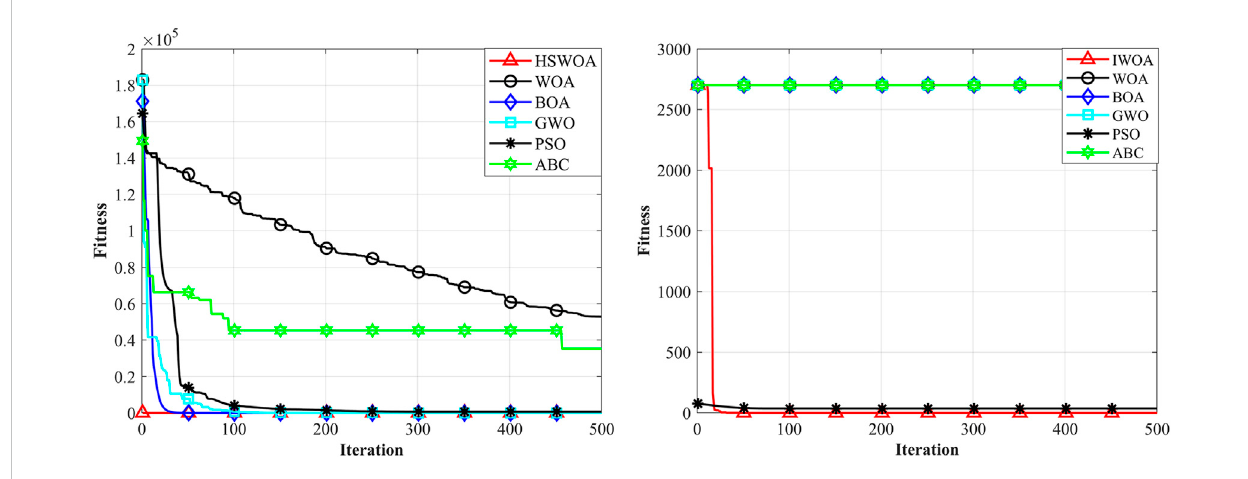
FIGURE 8 Algorithm convergence